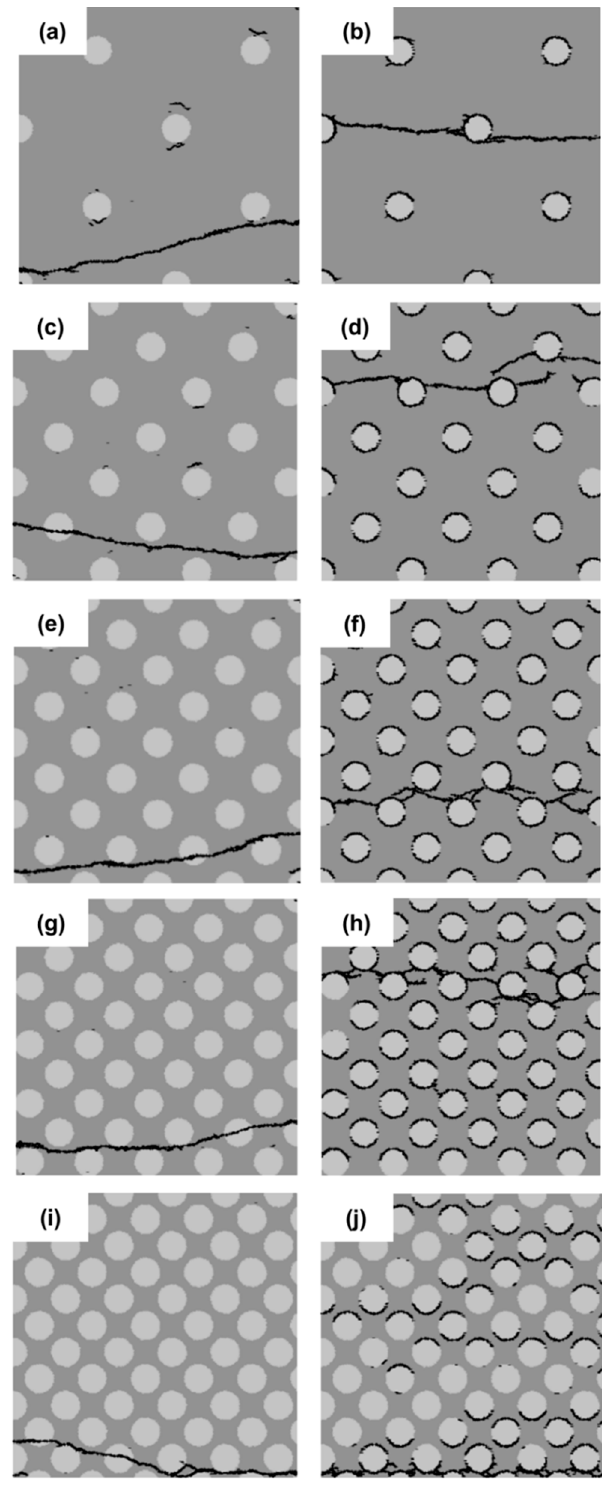
Figure 14. Micro-crack patterns of specimens with uniformly-distributed filler particles and five different filler area fractions (5% ( a , b ); 15% ( c , d ); 25% ( e , f ); 35% ( g , h ) and 45% ( i , j )). Micro-crack patterns of the specimens with different filler content are shown in Figures 13 and